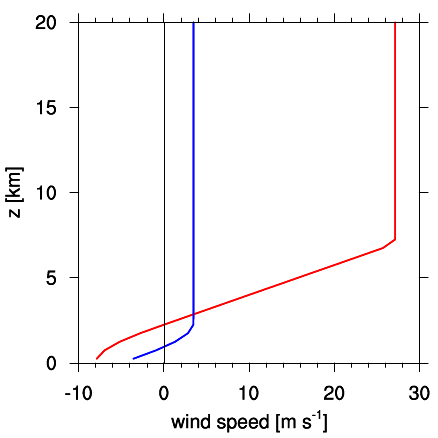
Fig. 2. Quarter circle shear wind profile. The zonal wind ( u ) is in red and and the meridional wind ( v ) is in blue. The values are derived following Weisman and Klemp (1982) as modified for in- clusion in